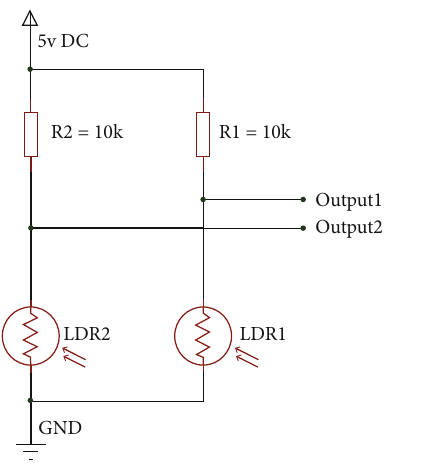
Figure 31: The electronic diagram of the solar captor.